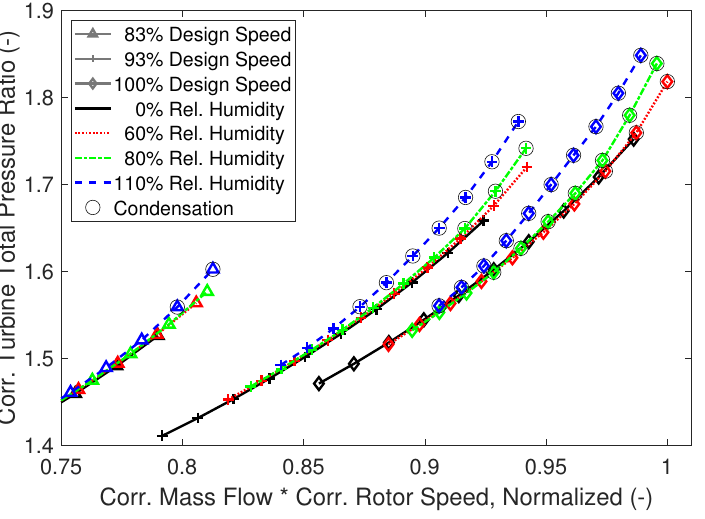
Figure 9. Section of the turbine performance map. Data taken from [10]. Grey circles indicate operating points with condensation of at least 0.1% of the vapor mass flow. The operating points of the same speed line overlap when there is no con- densation. However, as soon as condensation sets in, the speed lines with condensation split off from the others to higher pressure ratios. This shows the influence of thermal throttling on the turbine performance map. The higher the pressure ratio and the